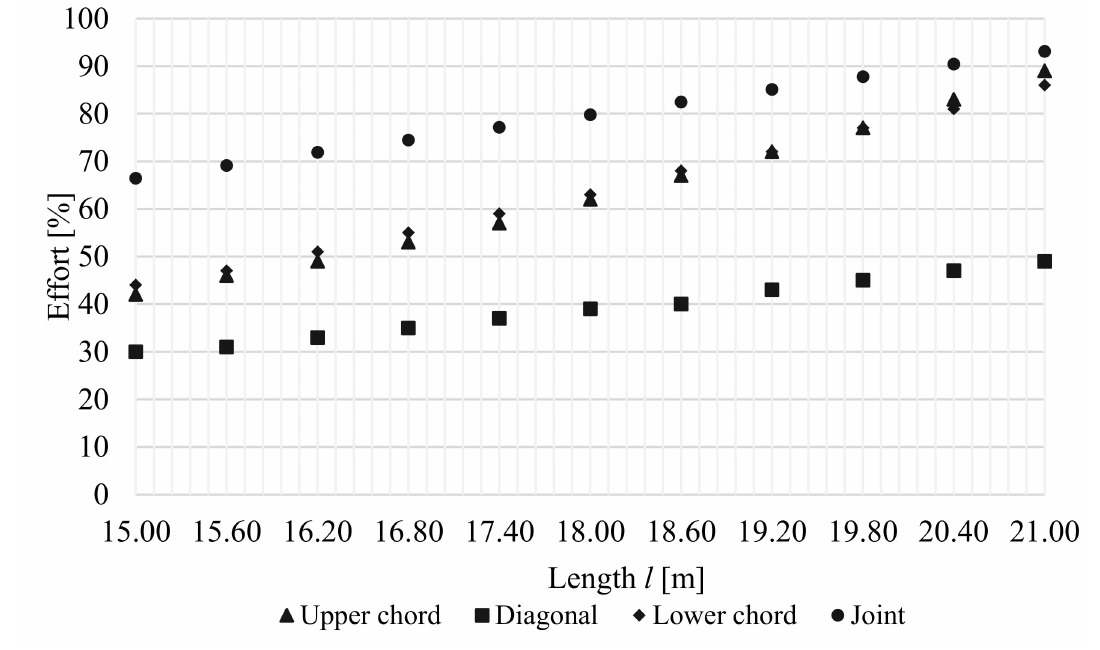
Figure 4. Structural effort variations of the Pratt truss structural components w.r.t. Pratt truss